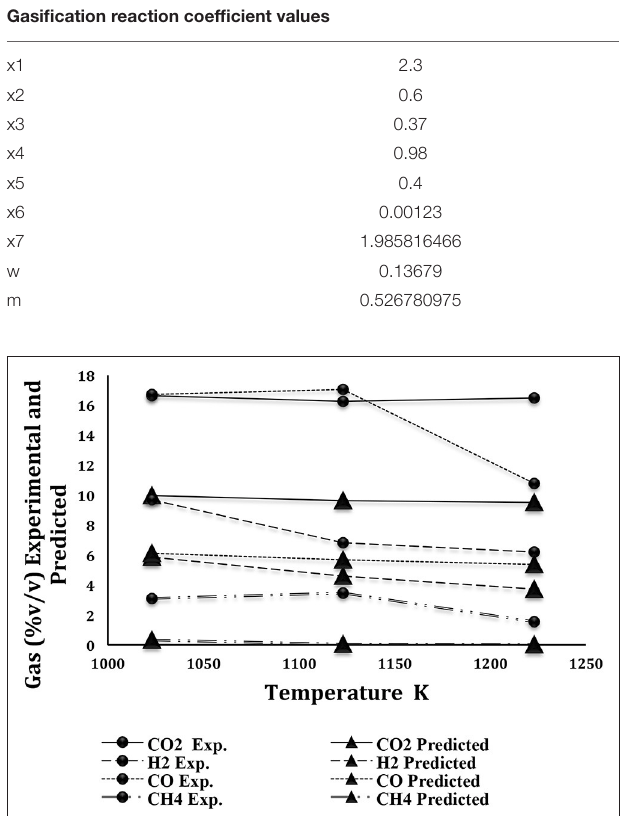
FIGURE 7 | Experimental and Predicted Product Gas Compositions vs.